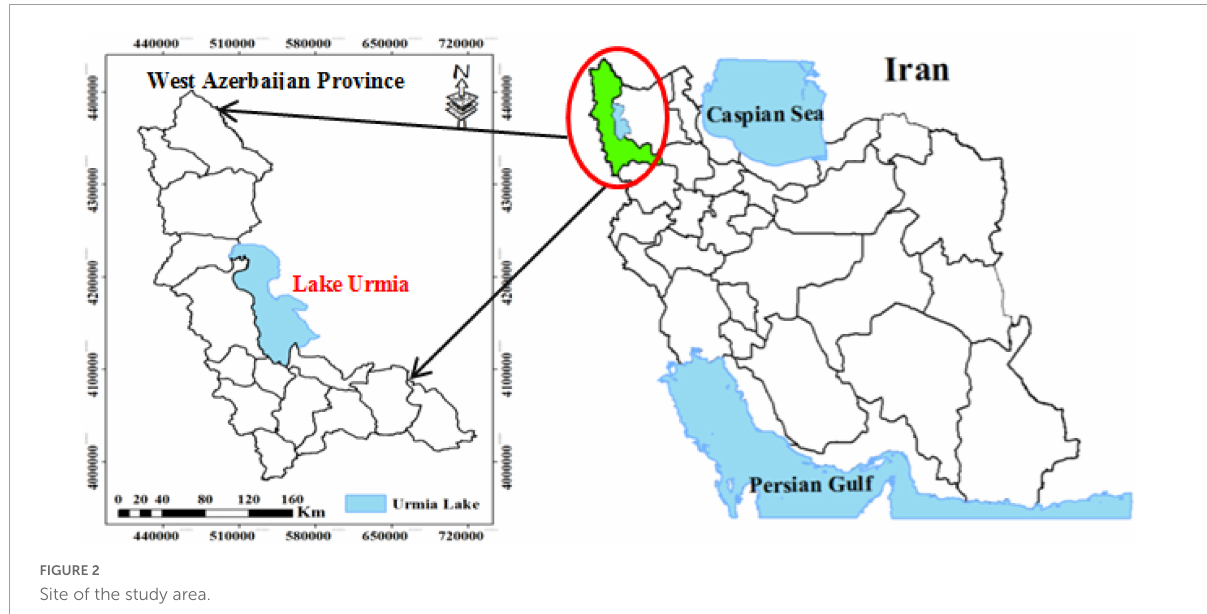
FIGURE2 Site of the study